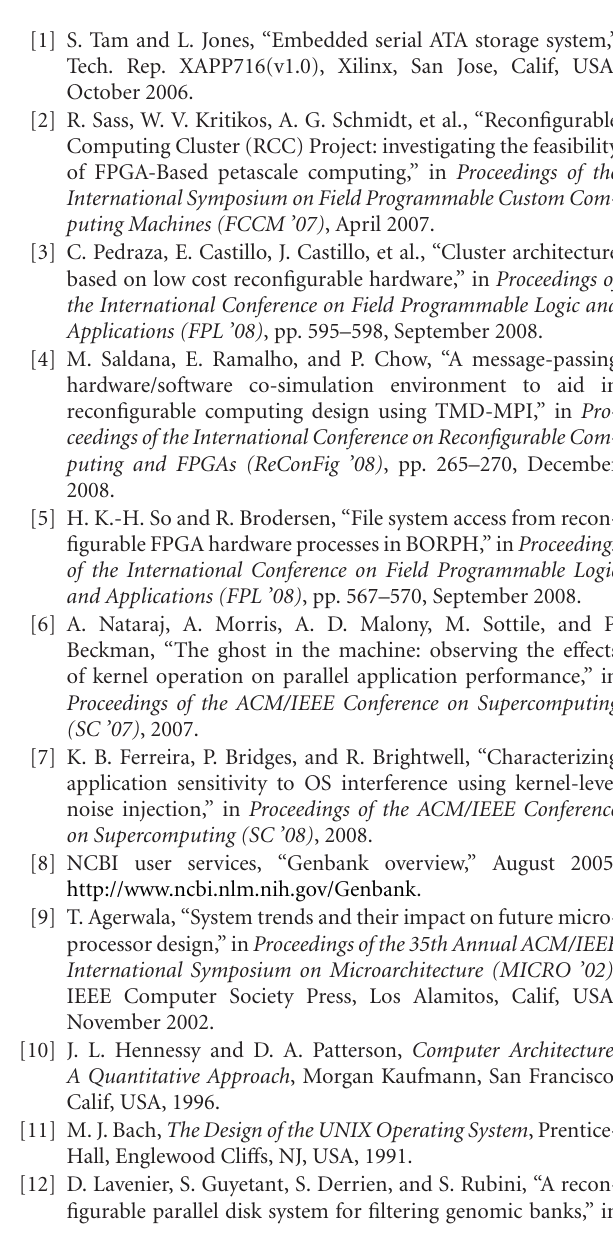
figurable parallel disk system for filtering genomic banks,”